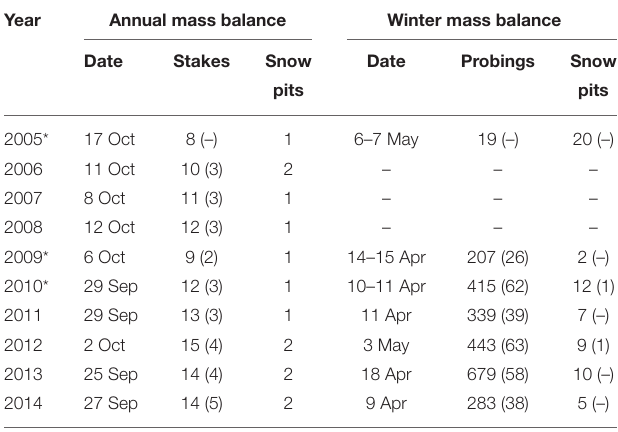
TABLE 1 | Dates of the annual and winter mass balance measurements on Findelengletscher and the respective number of stakes, snow pits, and probings (values for Adlergletscher in parentheses).